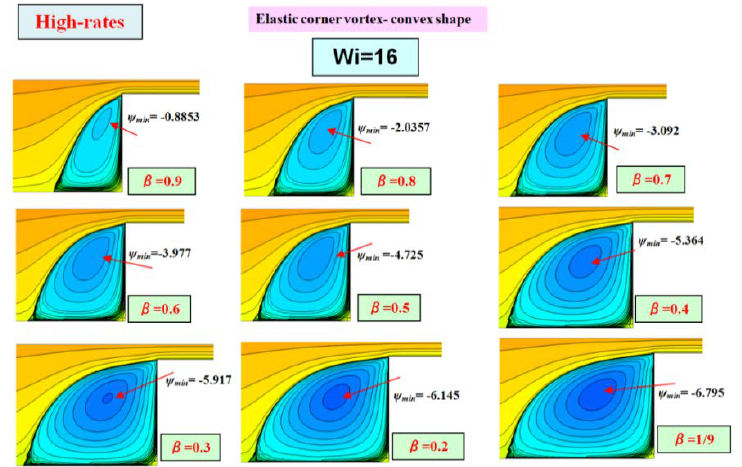
Figure 8. Streamlines; α aspect = 8; medium flow-rates: ( a ) Wi = 3, ( b ) Wi = 5; swIM [ L = 5, λ D = 0.075]; 1/9 ≤ β ≤ 0.9.